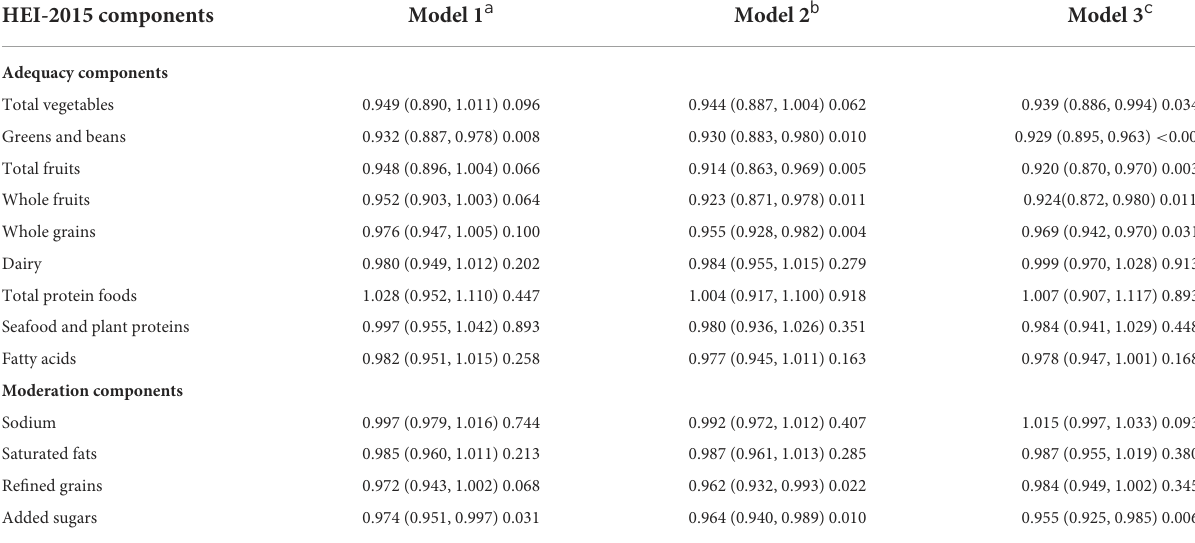
TABLE 3 Association of HEI-2015 components with